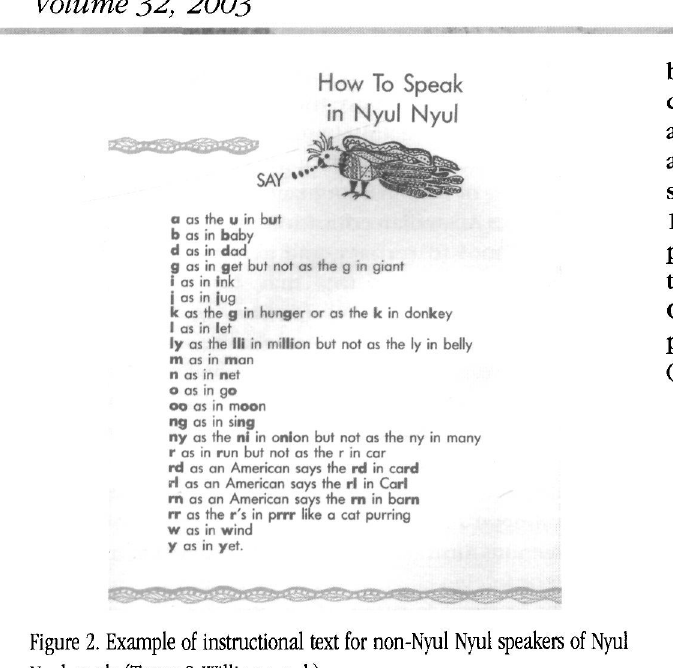
Figure 2. Example of instructional text for non-Nyul Nyul speakers of Nyul Nyul words (Torres & Williams,